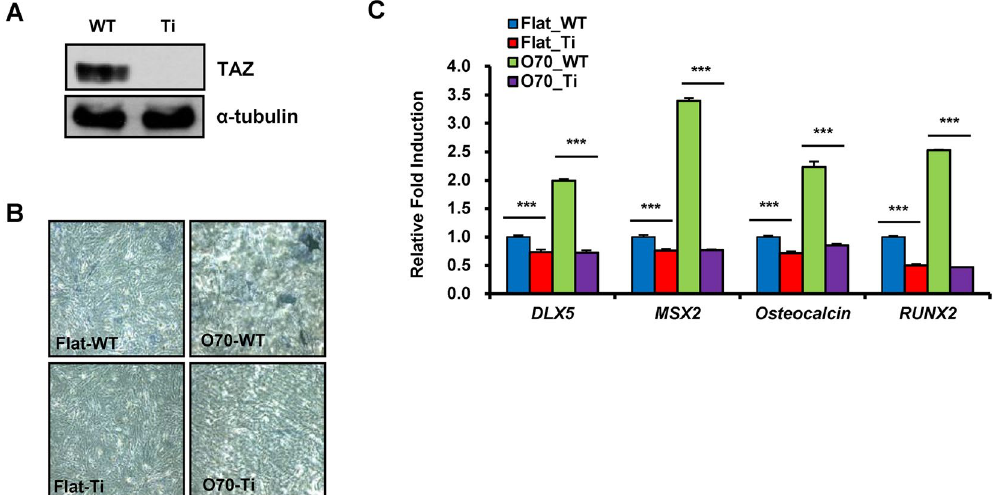
Figure 4. TAZ is required for the osteogenic differentiation of MSC by nanopattern plates. ( A ) TAZ knockdown human MSC were generated using lentivirus-mediated transduction of shRNA. The cells were analyzed by immunoblotting to prove TAZ knockdown. Full length blots cropped for representative Figure are shown in Supplementary Figure S3. ( B ) Wild type and TAZ knockdown MSC were seeded on flat or nanopattern plate and differentiated to osteoblasts. Six days after differentiation, cells were stained using the alkaline phosphatase staining method. ( C ) Cells in panel (B) were harvested and the transcripts of osteogenic marker genes were analyzed by qRT-PCR. Data are shown as relative fold induction. n = 3, *** p < 0.005, t-test.